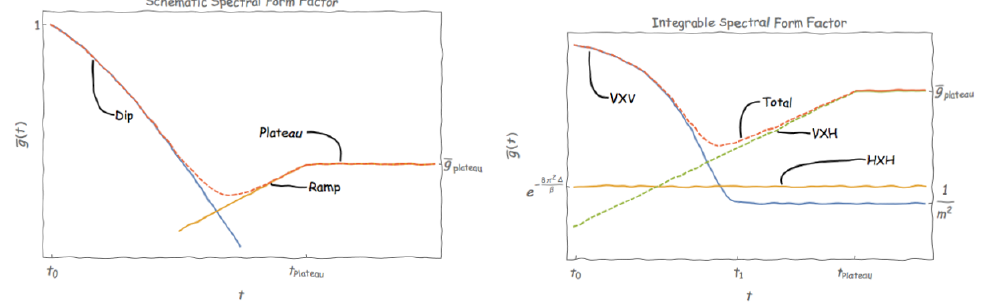
Figure 7 . Left: a schematic form for the SFF in a typical chaotic theory. Right: a plot of the purported large m behavior of the SFF in our integrable models. The solid lines correspond to bounds or asymptotic behavior derived in the text; the dashed lines correspond to conjectured large m behavior for the V (cid:2) H component.